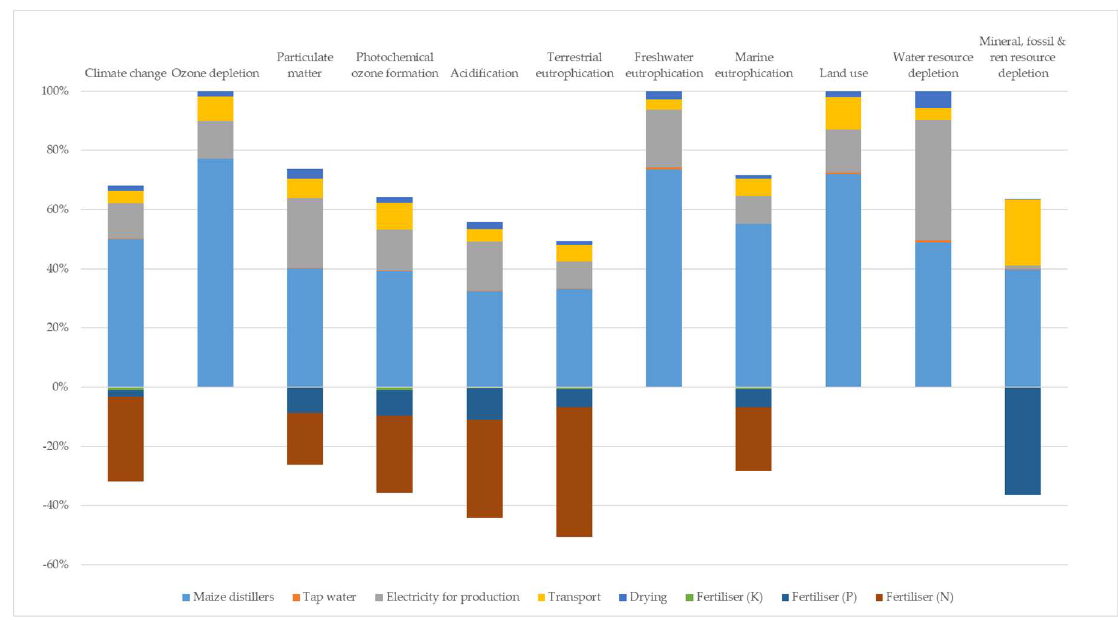
Figure 3. Relative weight of different processes of larvae grown on maize distiller.